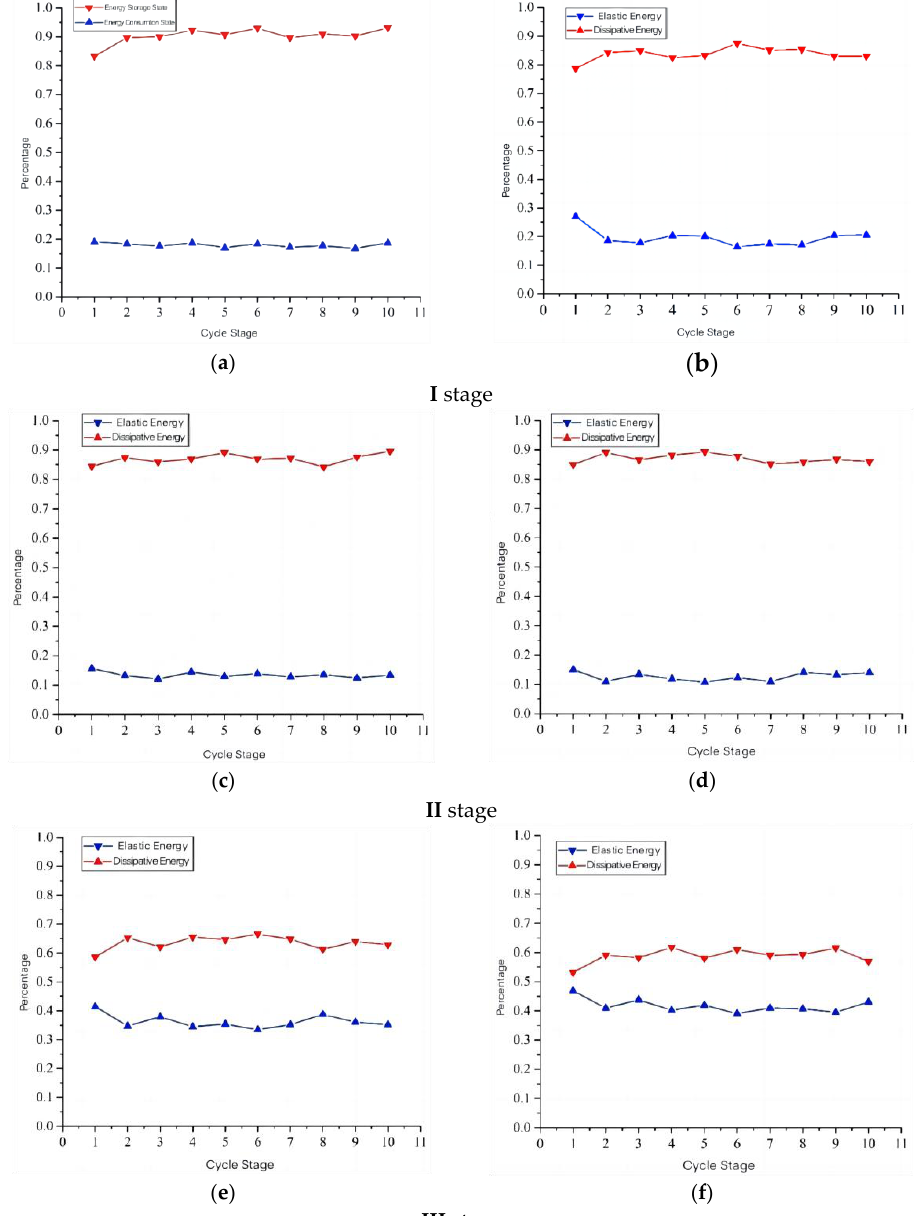
Figure 8. The energy accumulation and dissipation during equal amplitude loading/unloading. ( a ) Results of cyclic loading of coal sample S3 in stage I ( b ) Results of cyclic loading of coal sample S4 in stage I ( c ) Results of cyclic loading of coal sample S3 in stage II. ( d ) Results of cyclic loading of coal sample S4 in stage II. ( e ) Results of cyclic loading of coal sample S3 in stage III. ( f ) Results of cyclic loading of coal sample S4 in stage III.